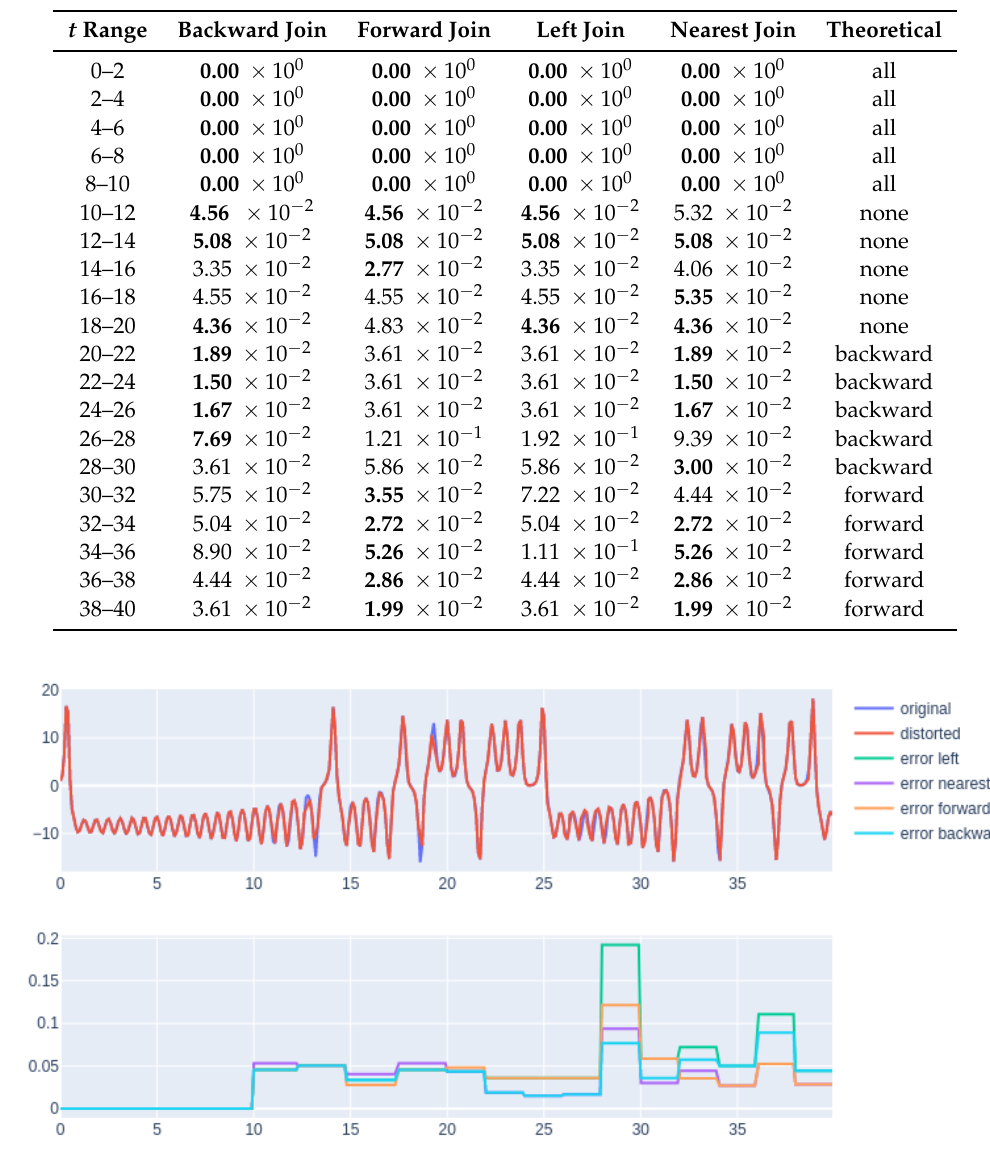
Table 7. Results on synthetic data, in bold the method with minimal error (multiple solutions are possible). t Range